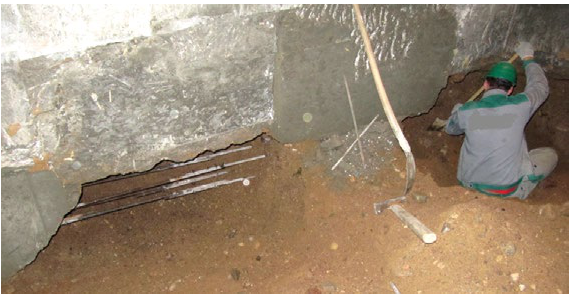
Fig. 4. Madding excavations by